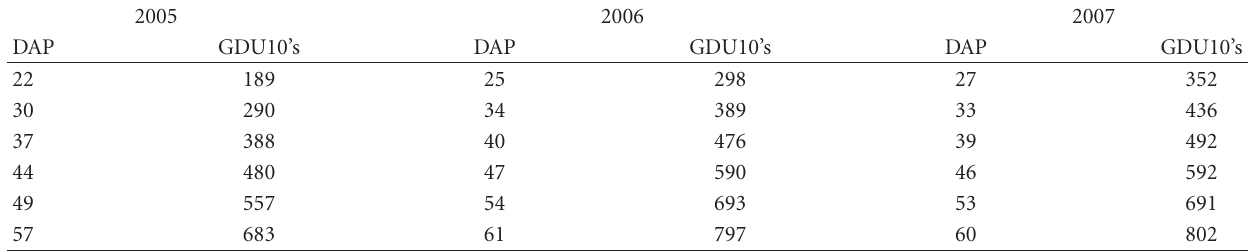
Table 2: Sampling Periods (days after planting (DAP)) and Accumulated Growing Degree Units 10 C base (GDU10’s) for LAI and Dry Weight Accumulation of Herbicide Resistant Corn Hybrids Grown at Stoneville, MS.